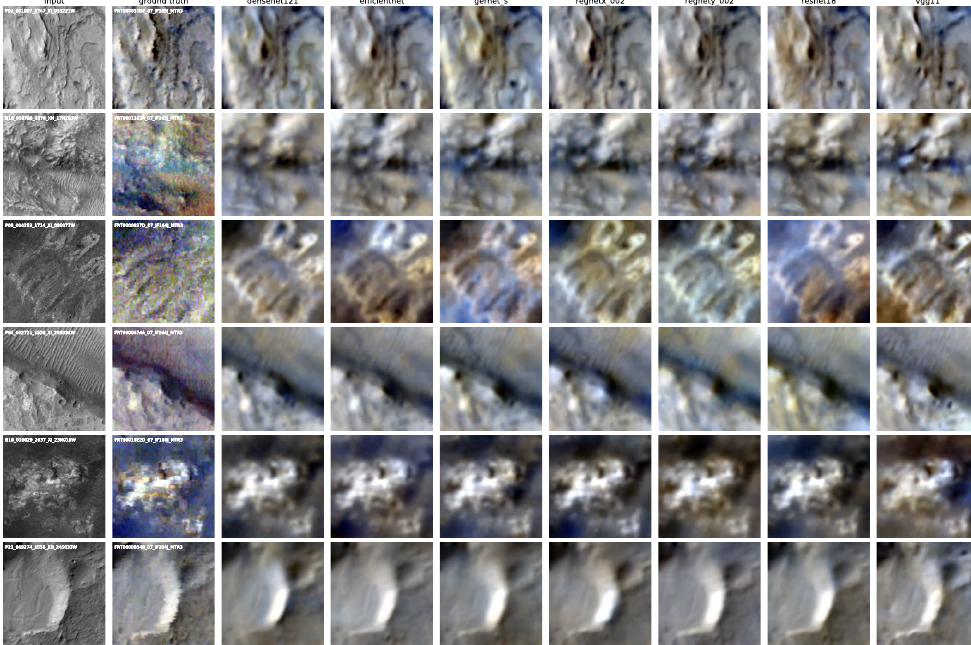
Figure 9. Appearance comparison of six EVC test patches across different encoder networks. Table 3. Comparison of EVC performance metrics across different encoder networks. Root mean squared error (RMSE), cosine similarity (Cosine), and the Pearson correlation coefficient (PCC) are presented. Memory reflects the maximum memory consumption during training and time reflects the average training time per